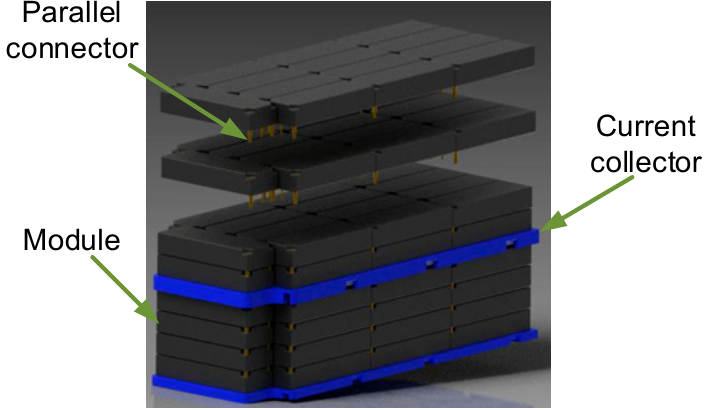
Figure 10. Final assembly of the battery-pack.